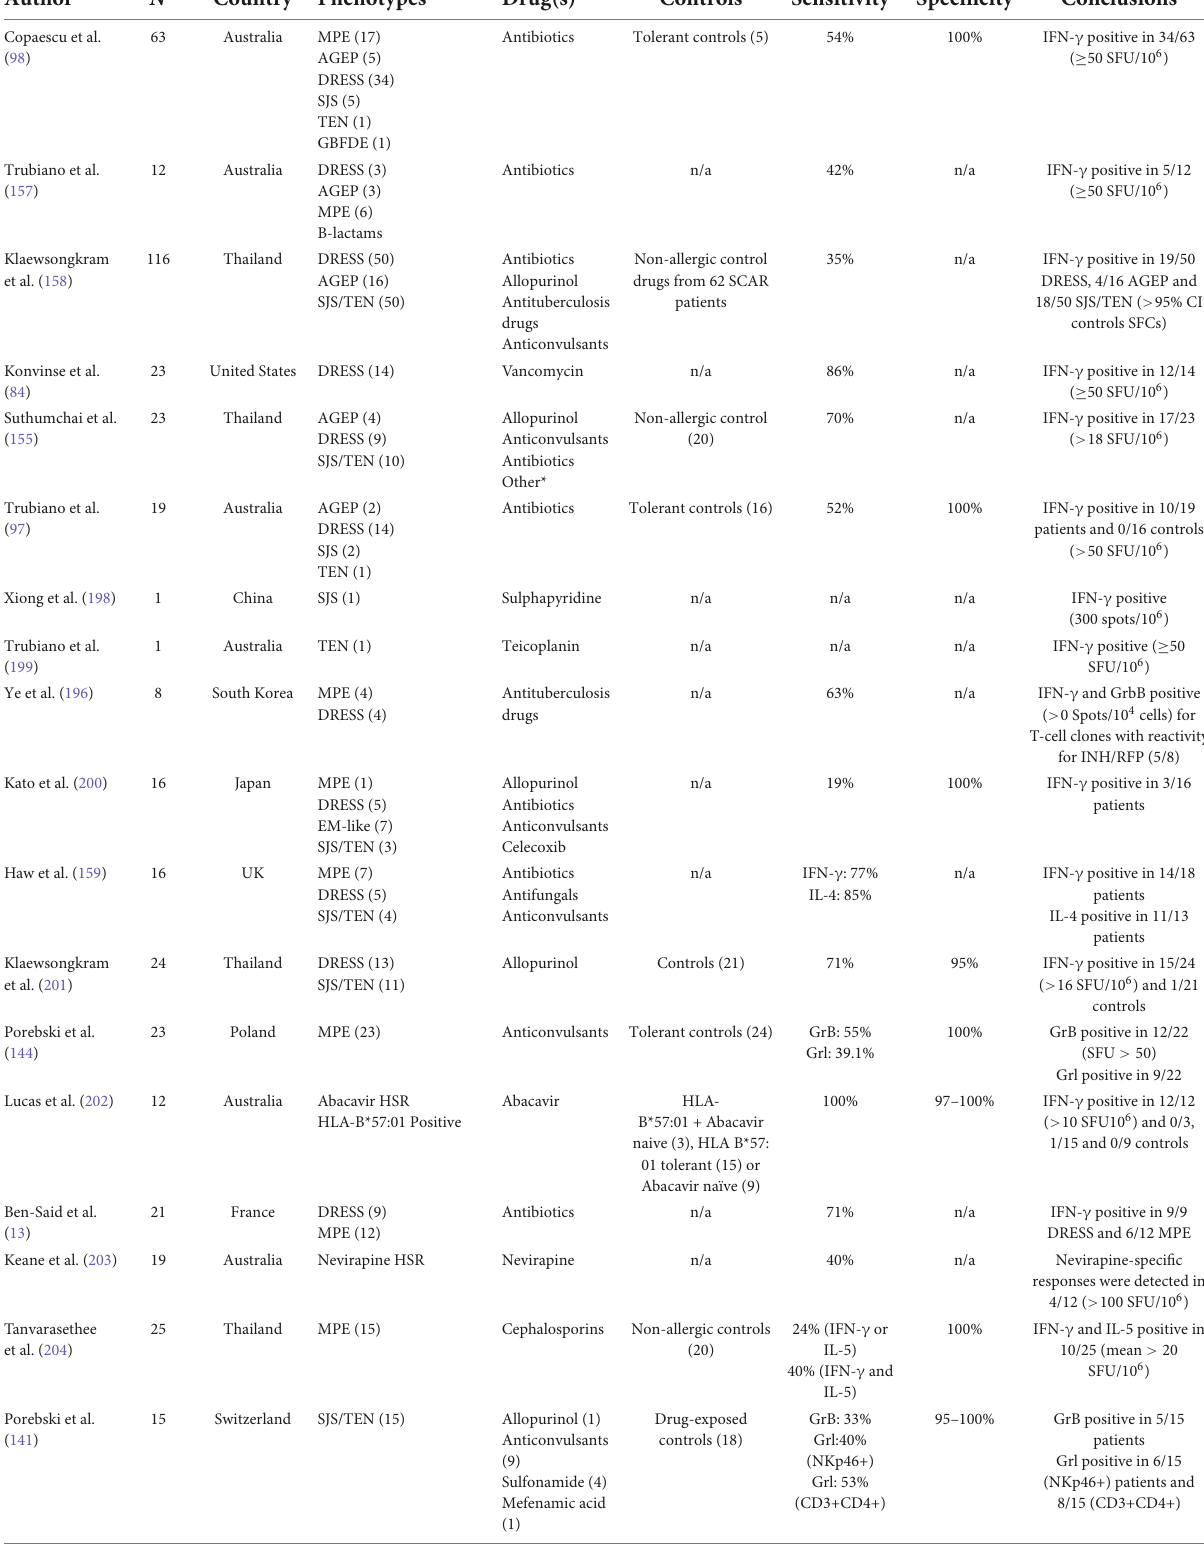
TABLE 5 Reported cases and cohorts showing clinical advantage with the use of the